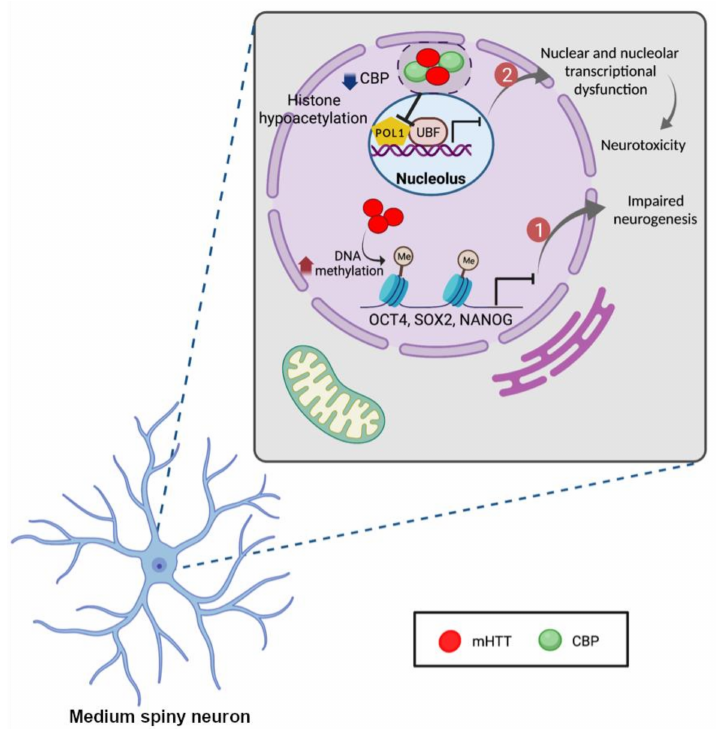
Figure 3. Epigenetic modifications associated with HD. The promoter regions of neurogenesis- related genes, OCT4 , SOX2 , and NANOG , are methylated in cells expressing mHTT which can lead to impaired neurogenesis. On the other hand, mHTT sequestrates CBP in nuclear inclusions which causes the hypermethylation and hypoacetylation of histone proteins and CBP depletion. Depletion of CBP from the nucleus of cells leads to histone hypoacetylation, nuclear and nucleolar transcriptional dysfunction and increase in neurotoxicity. Created with